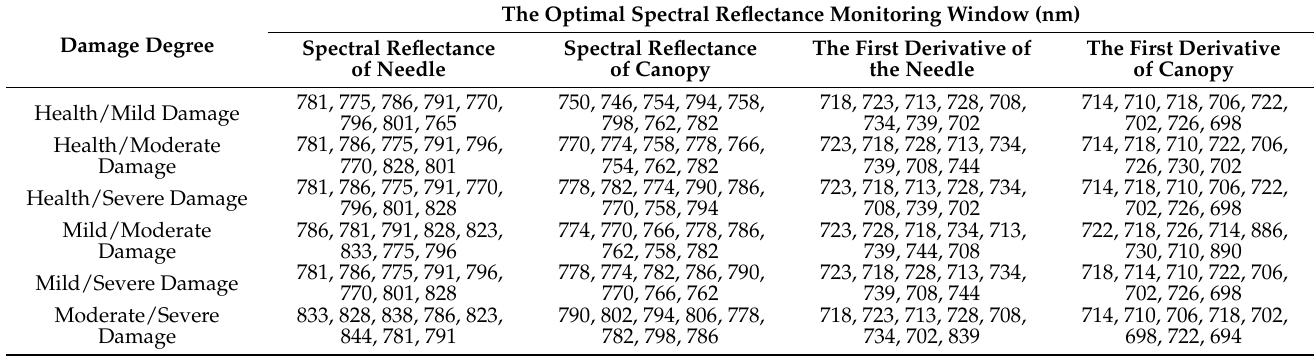
Table 7. Comparison of the best monitoring windows of different damage